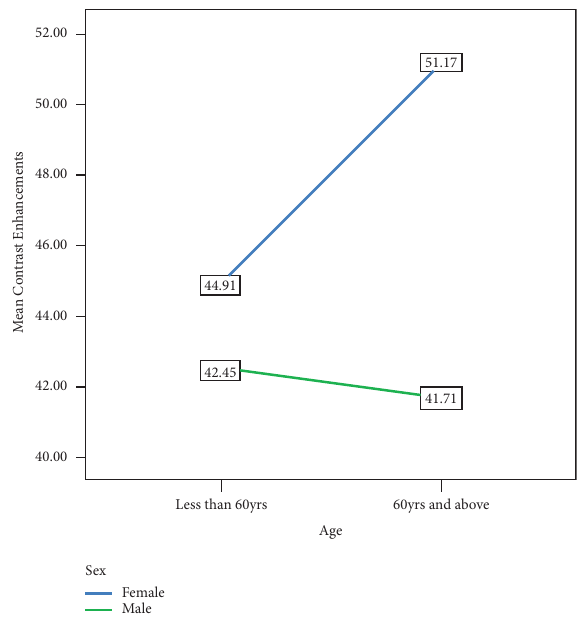
Figure 8: Mean contrast enhancements (CEIs) based on age and sex for patients evaluated with postcontrast abdominopelvic CT scans at TASH, Addis Ababa, Ethiopia, 2022